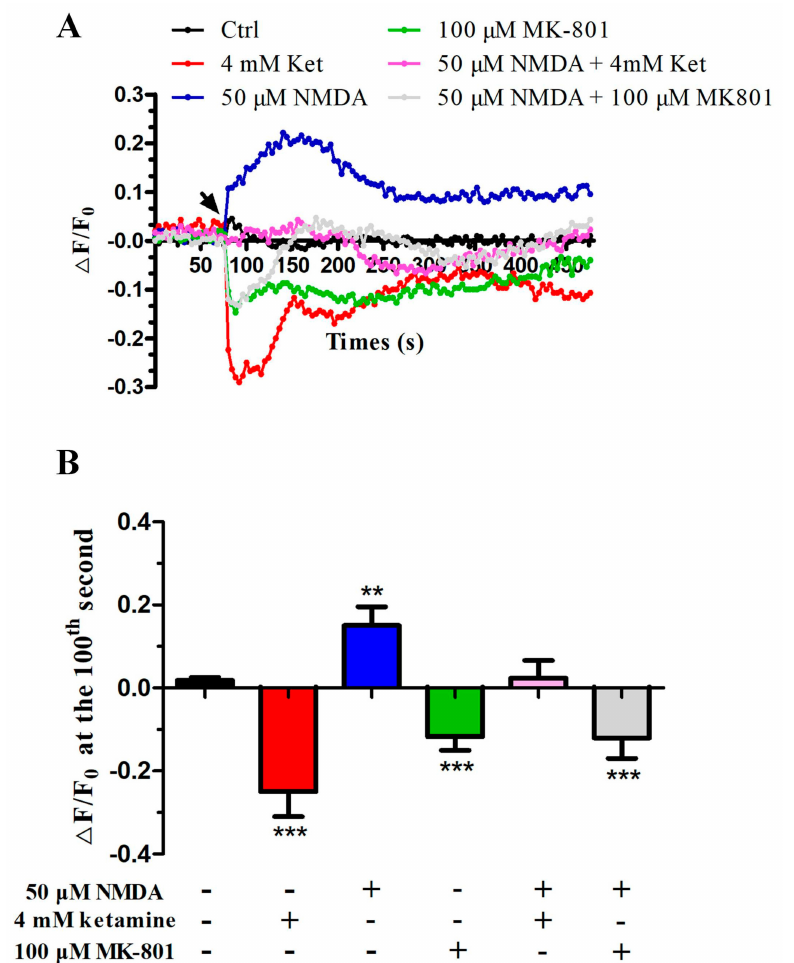
Figure 4. The NMDA receptor involved in ketamine suppression effects on the intracellular calcium concentration of human sperm. ( A ) Time course curve of real-time changes in human sperm [Ca 2+ ] i . The arrow indicates the time when ketamine (4 mM), NMDA (50 µ M), MK801 (100 µ M), and NMDA (50 µ M) plus ketamine (4 mM)/MK801 (100 µ M) were added into the sperm samples. ( B ) Inhibition effects of different chemicals on human sperm [Ca 2+ ] i at the 100th second as calculated by ∆ F/F 0 from the time course curve through statistical analysis. Bar: mean ± SEM, n = 7, one-way ANOVA; ** p < 0.01, *** p <